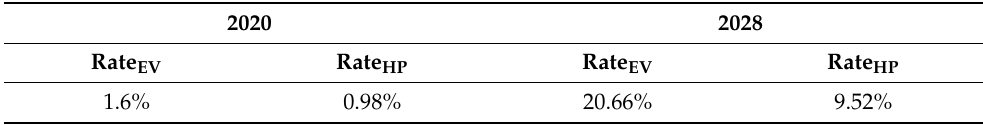
Table 5. Adoption rate of EVs and HPs in 2020 and 2028.